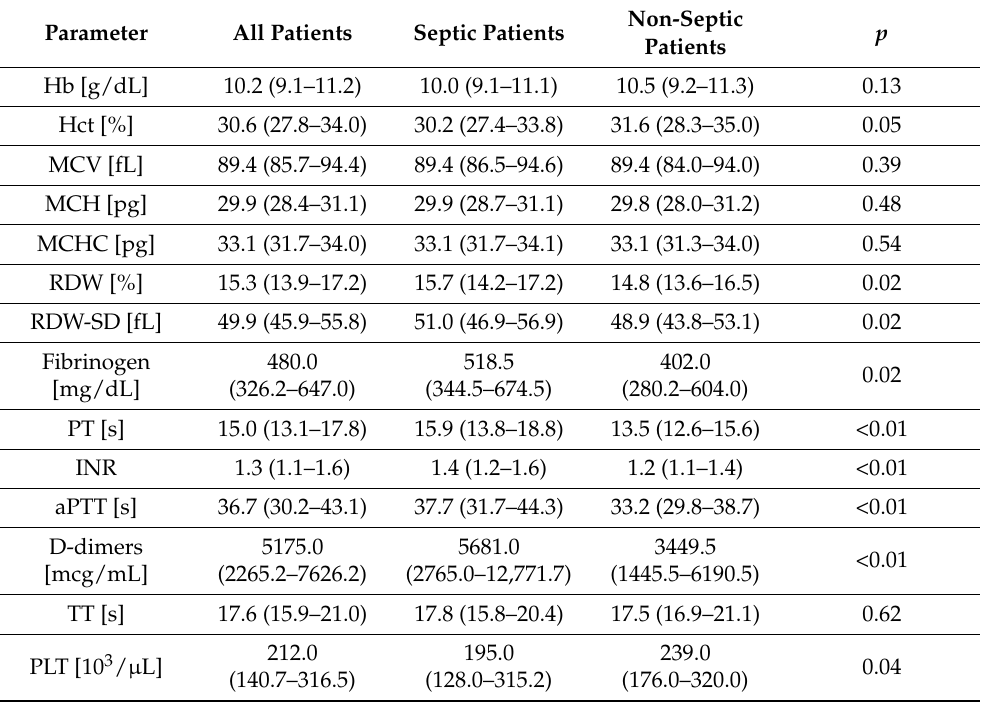
Table 3. Analyzed parameters on admission to ICU in septic and non-septic